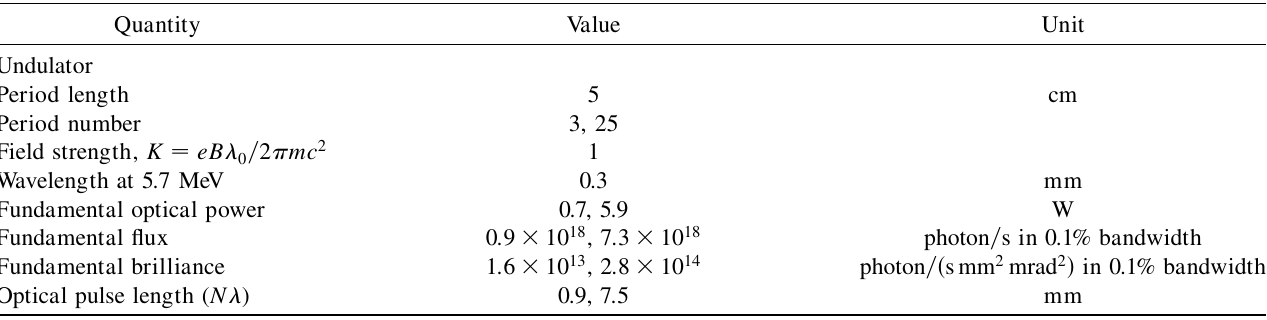
TABLE II. THz source undulator and calculated optical